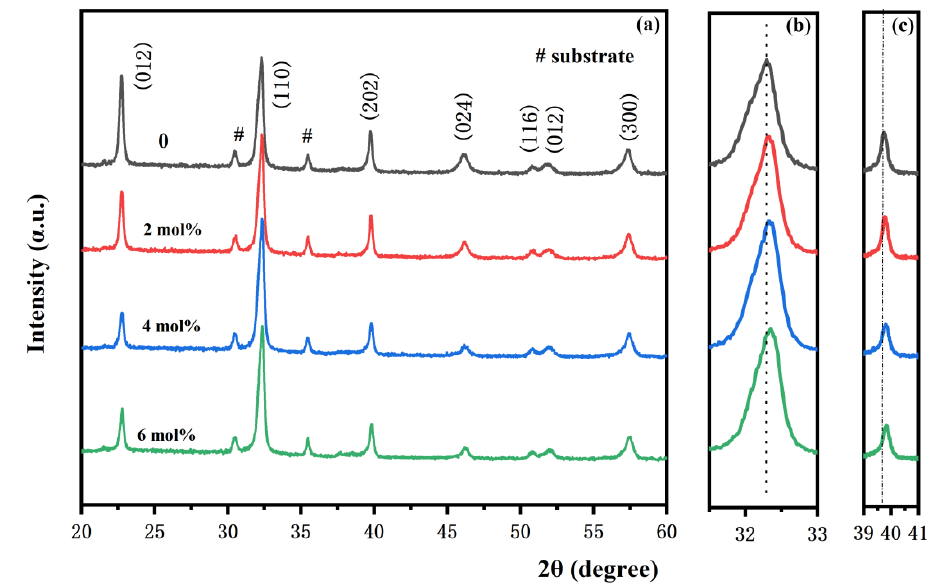
Figure 1. ( a ) XRD patterns, ( b ) magnified patterns around 30.5° – 33°, and ( c ) magnified patterns around 39° – 41° of the BSFM films with different Sm content.